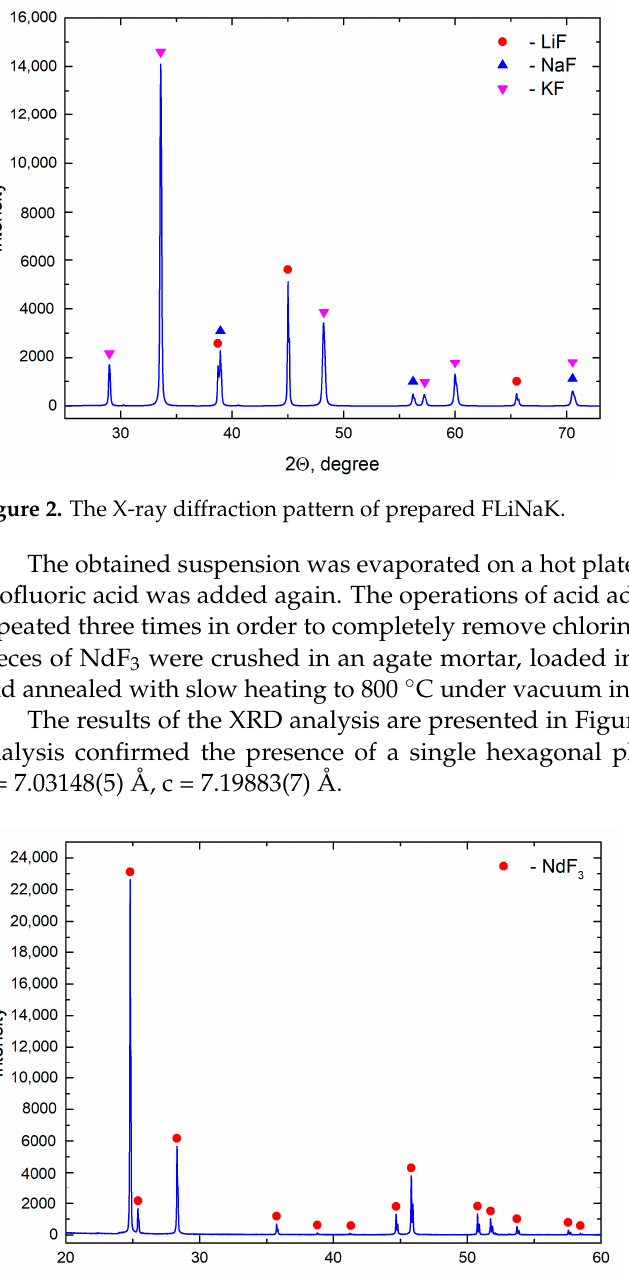
Figure 2. The X-ray diffraction pattern of prepared FLiNaK.